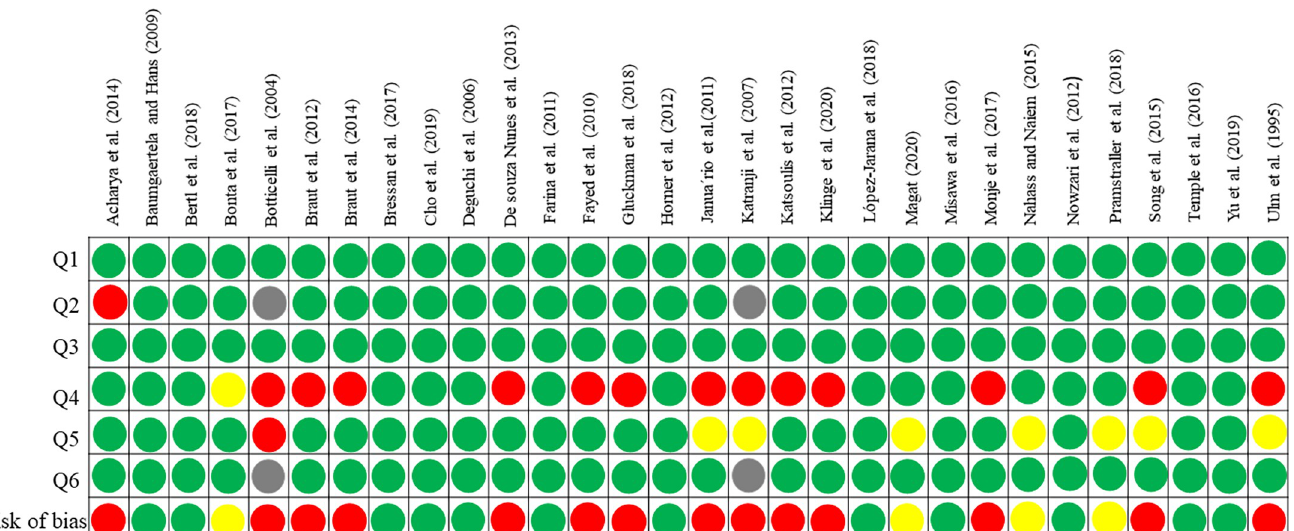
PLOS ONE | https://doi.org/10.1371/journal.pone.0253283 June 16,